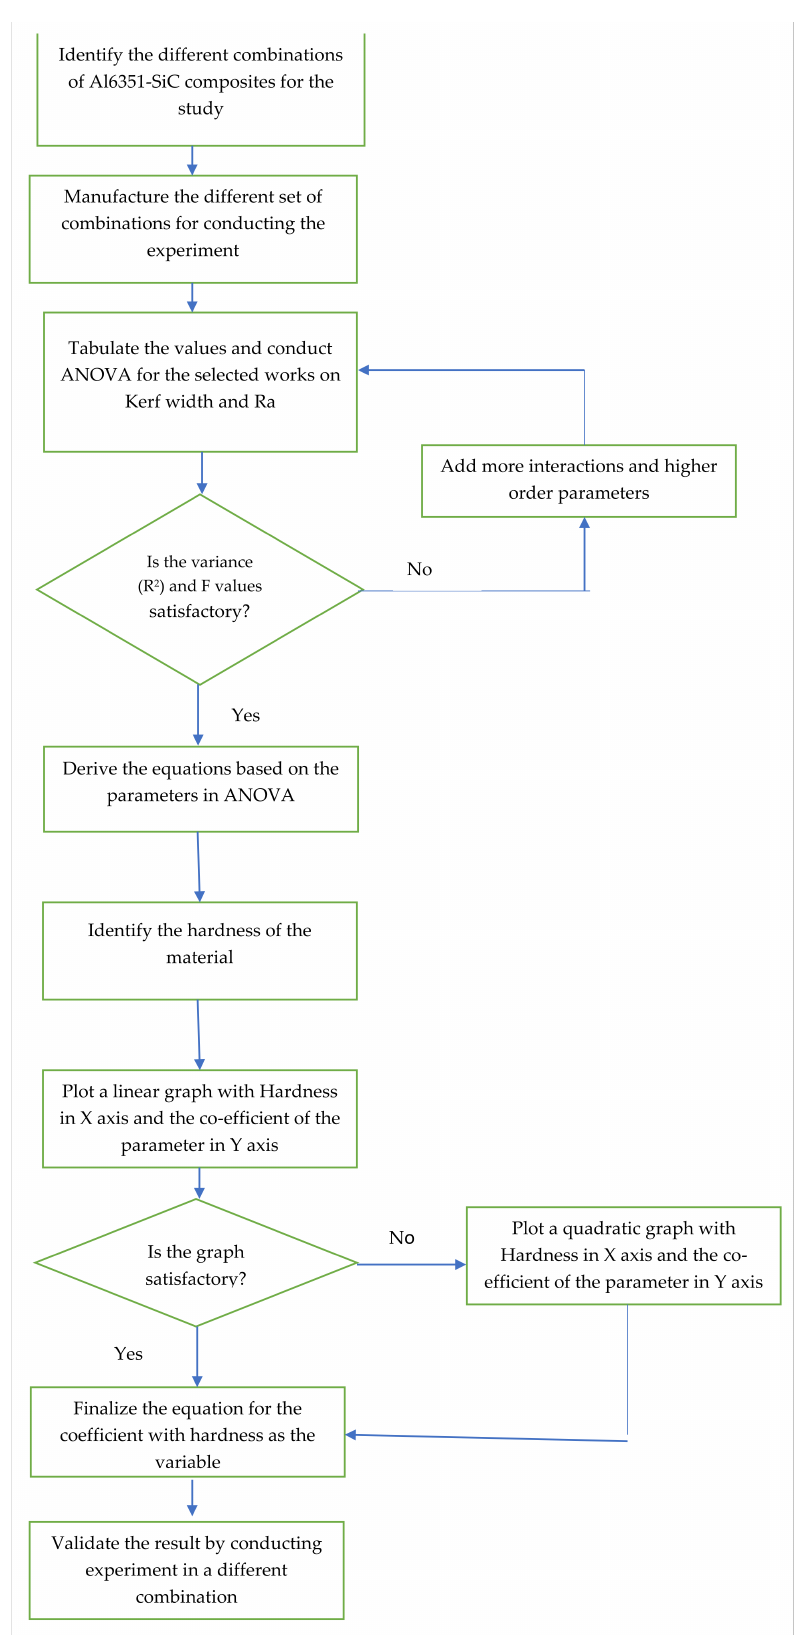
Figure 5. Flow chart of the methodology